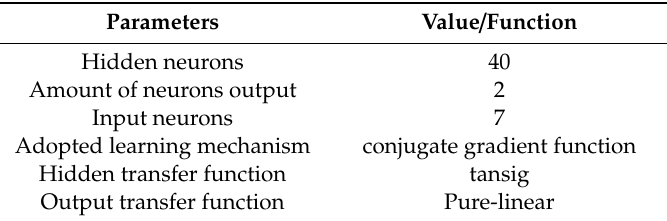
Table 5. Parameters for artificial neural network (ANN).